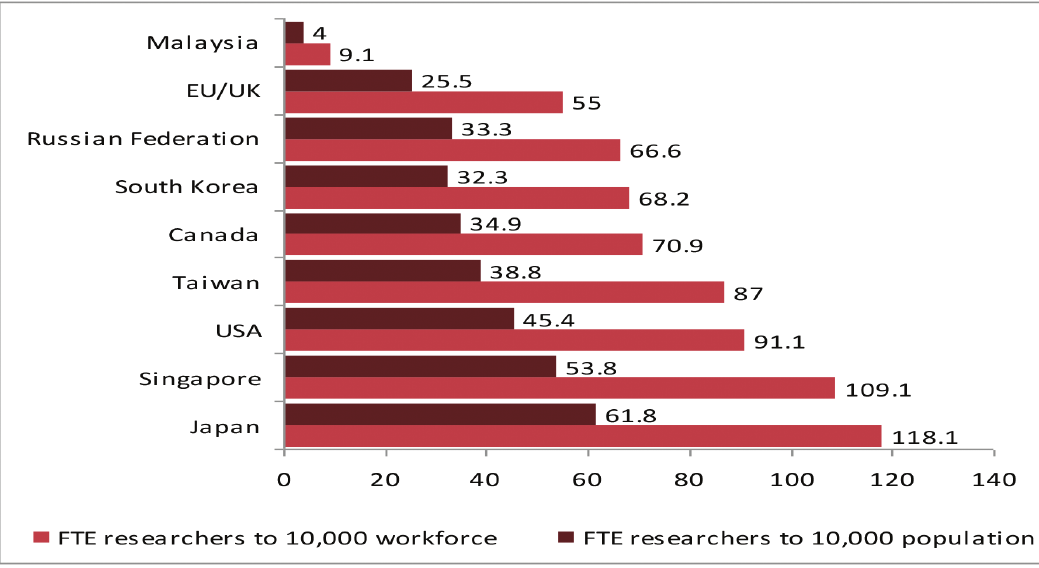
Figure 4 - Low Full Time Equivalent (FTE) – A barrier to sustained economic growth. Source: (1) APEC Industrial Science & Technology Internationalization Database, 2010. And (2) National Survey of Research & Development, 2008; adopted from MSF